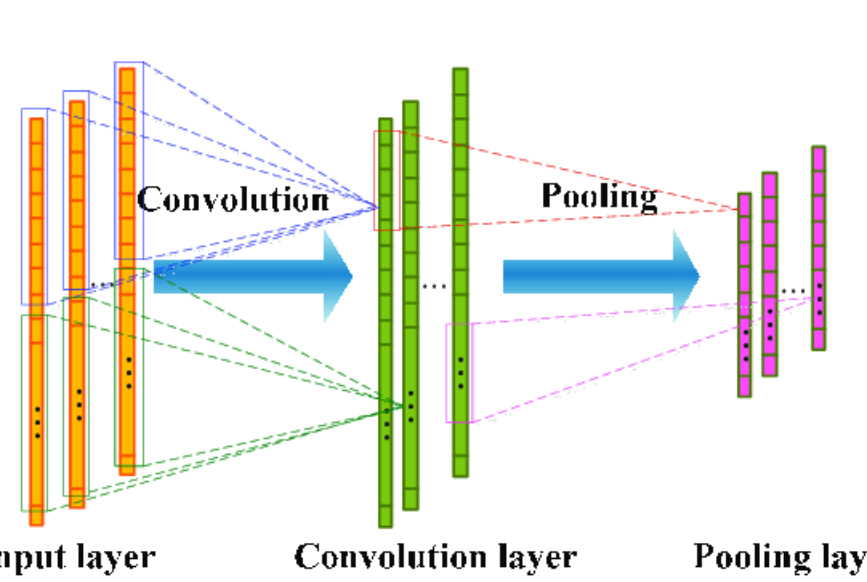
Figure 2. CNN one-dimensional structure